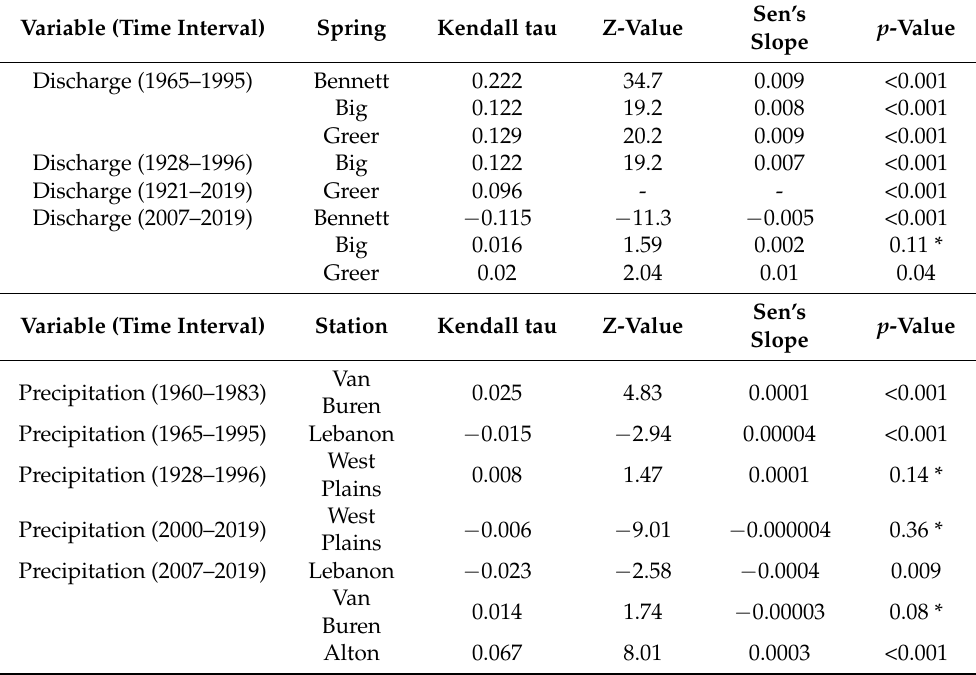
Table 3. Summary of Mann–Kendall trend test of the discharge for studied springs and rainfall. Kendall tau, Z-values, and Sen’s slope values represent means for each time series. Z-value and Sen’s slope were not calculated for Greer Spring for 1921–2019 time series because of the large number of data points. * indicates no statistical significance at a 95% confidence